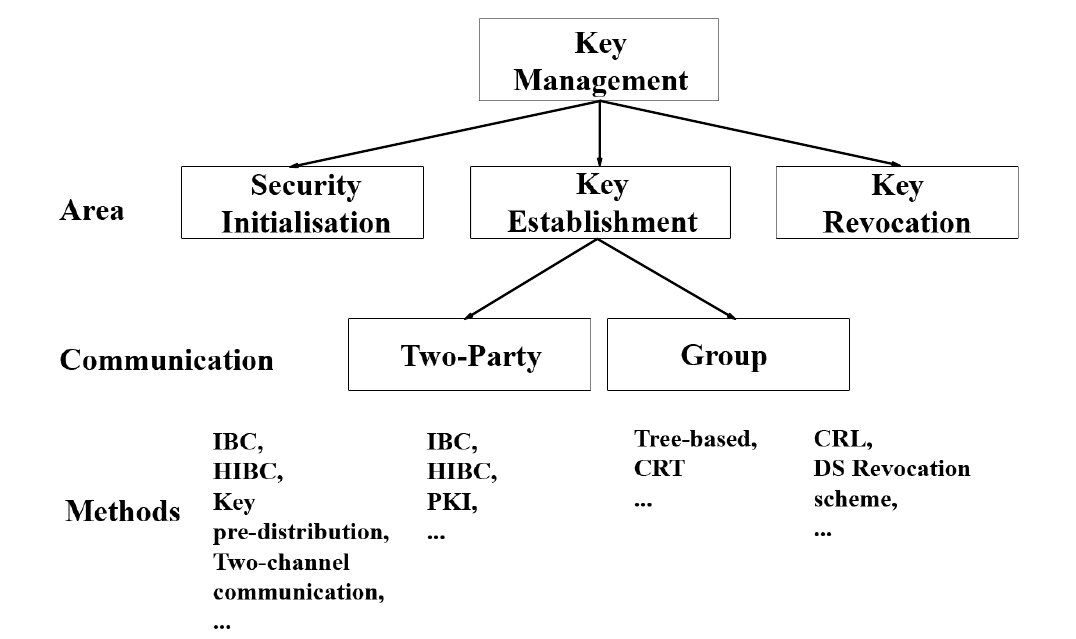
Figure 1. Key management